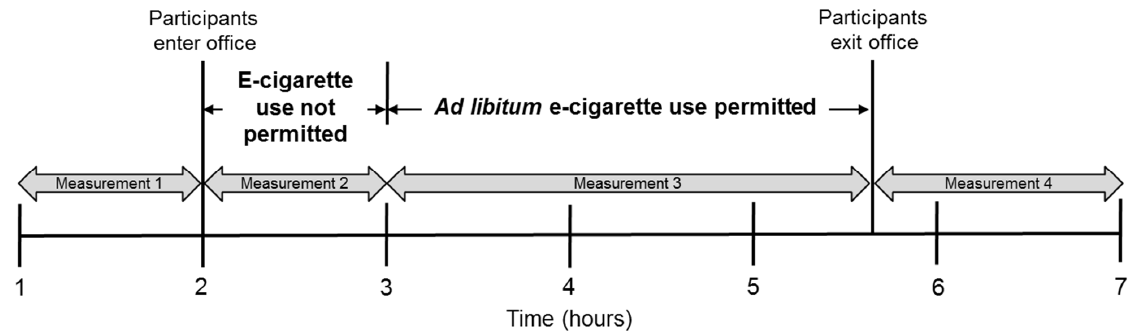
Figure 2. Timeline illustrating when participants entered and exited the office, when e-cigarettes were used and sampling